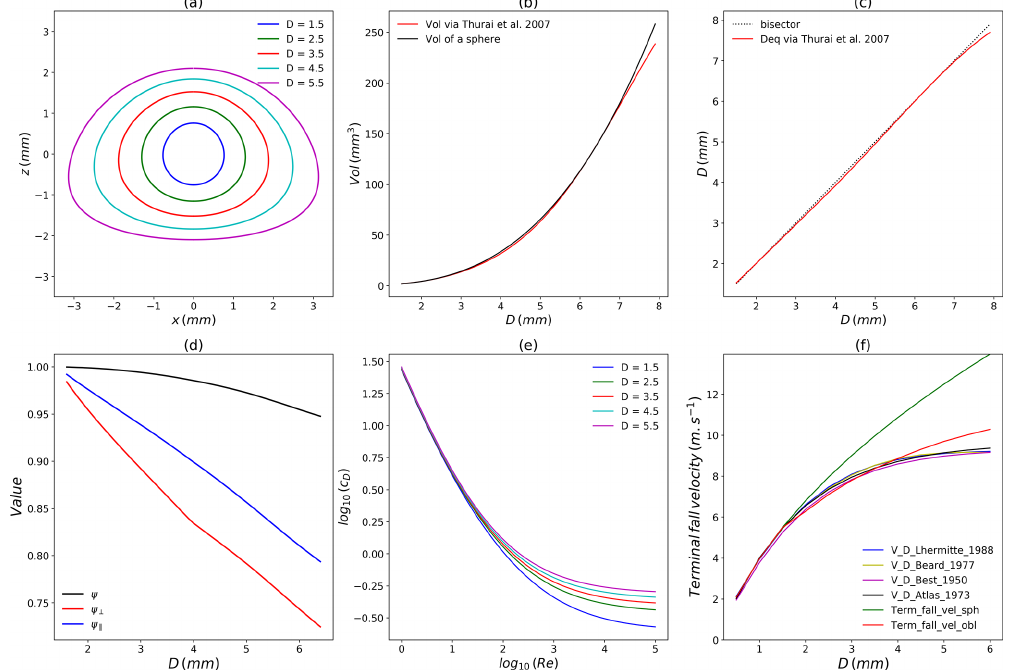
Figure 2. (a) Drop shape model used in this paper; (b) drop volume vs. equivolumic diameter; (c) diameter relation to retrieved wanted volume; (d) parameters characterising non-spherical shape of drops vs. equivolumic diameter; (e) drag coefficient c D vs. Re number and (f) terminal fall velocity vs. equivolumic